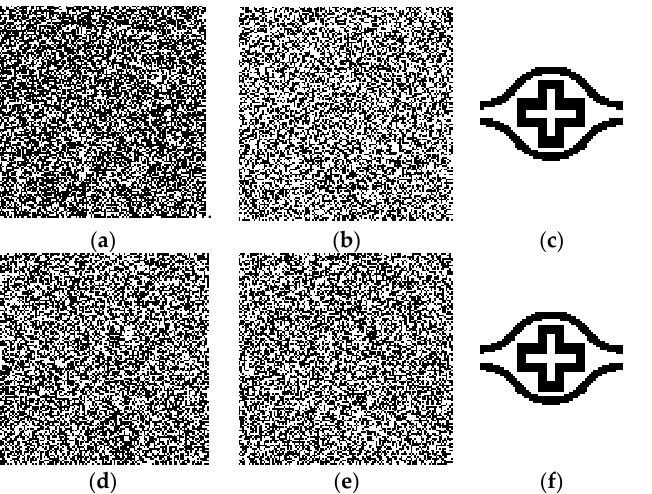
Figure 5. Watermark images used in the experiment: ( a ) 64 × 64 and ( b ) 32 × 32 .